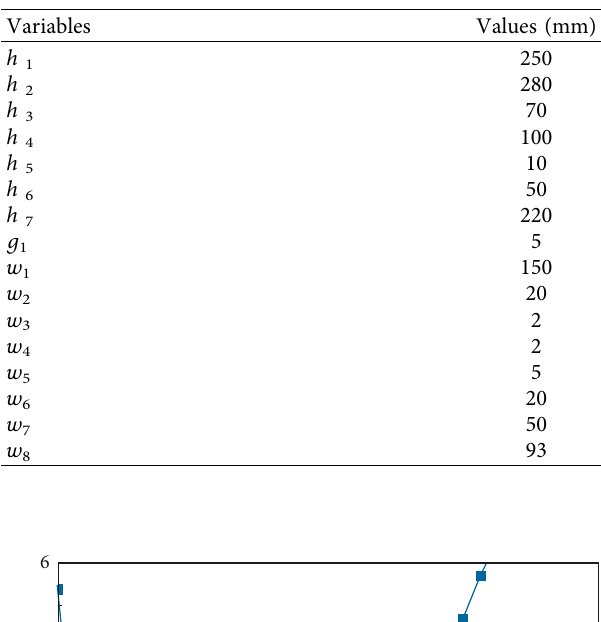
Figure 4: The simulated Smith charts of Ant. 1 and Ant. 2.